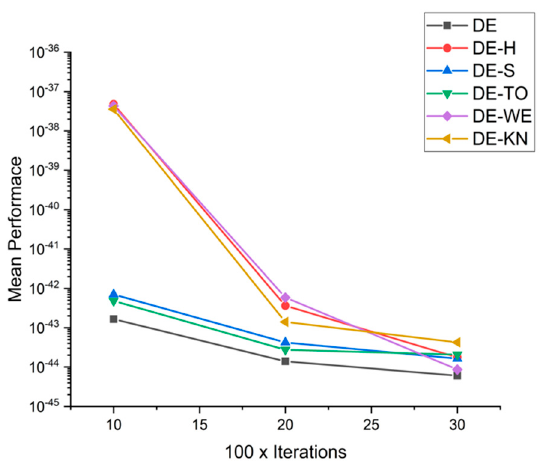
Figure 27. Convergence curve on fn5.